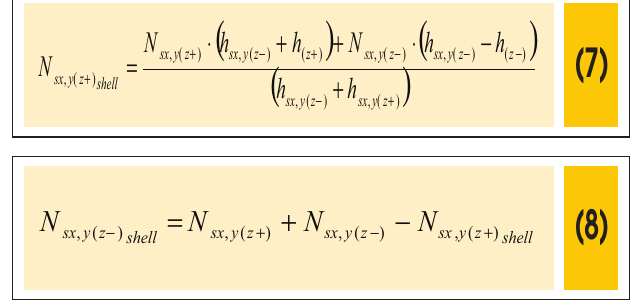
Figure 5 – Reinfoced concrete membrane